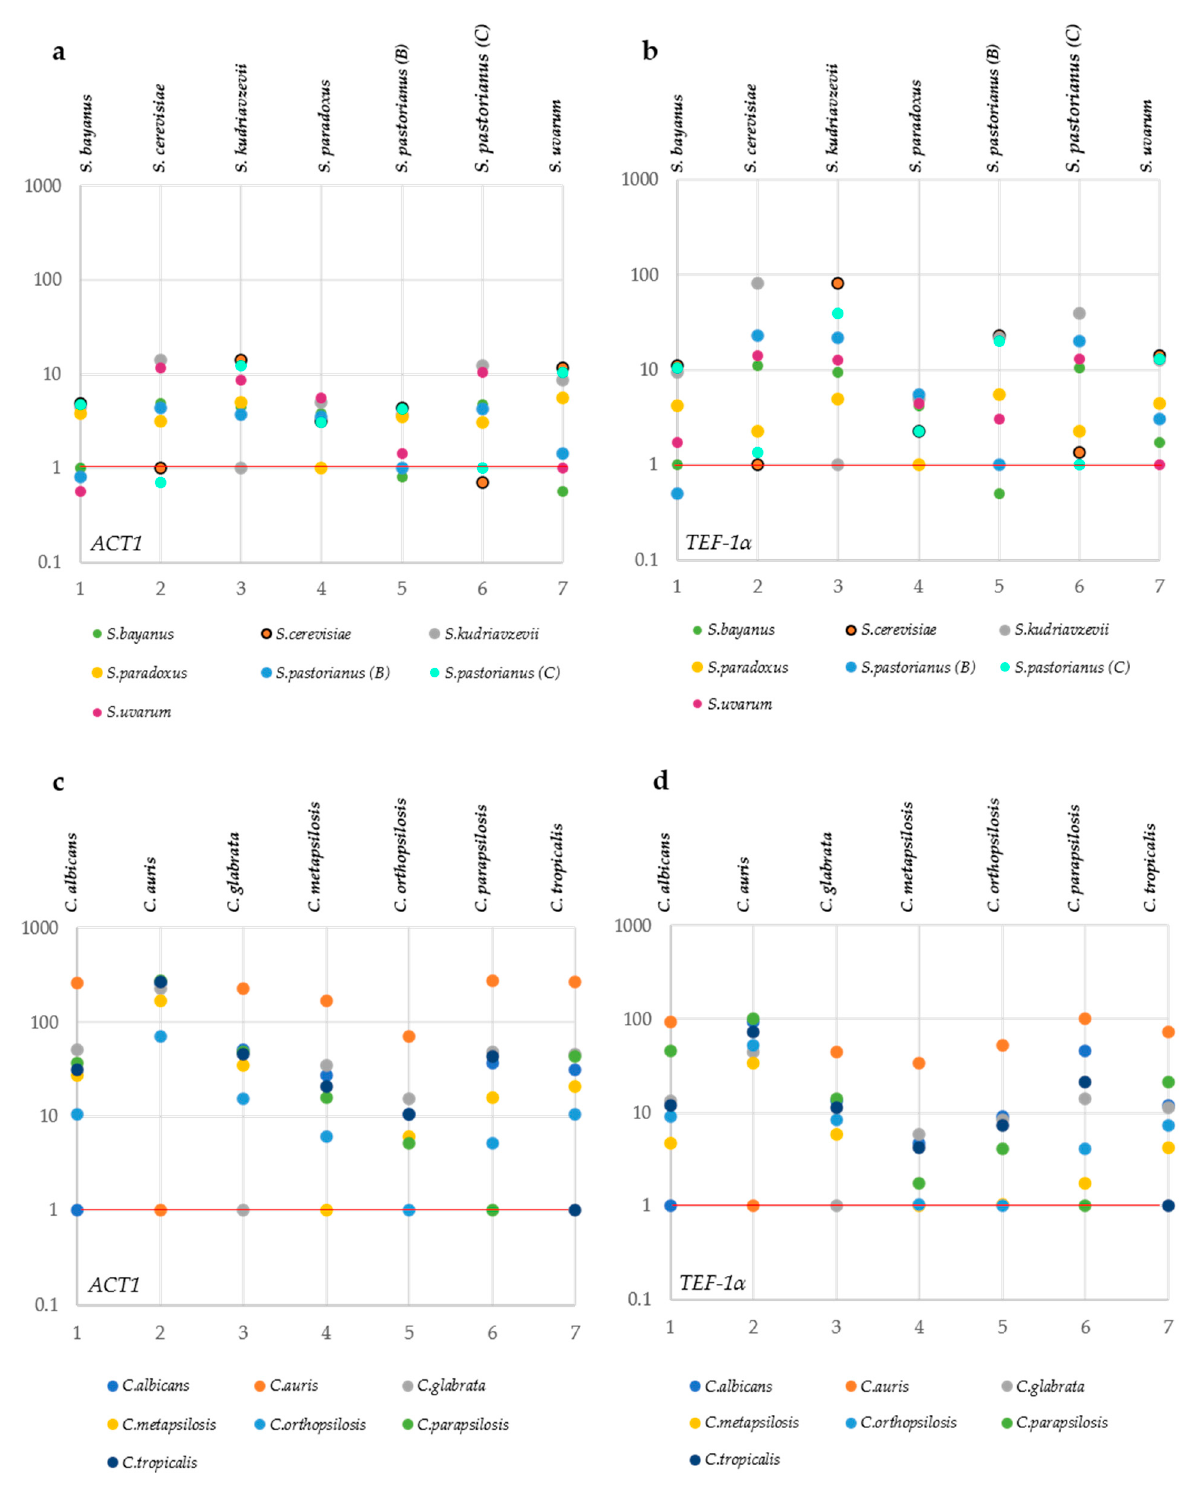
Figure 5. MeTRe among and within the Saccharomyces and Candida species for ACT1 and TEF1- α . Resolutions calculated for the genomic ACT1 and genomic TEF1- α of Saccharomyces are displayed in panels ( a , b ), respectively. Genomic ACT1 and genomic TEF1- α of Candida are reported in panels ( c , d ). Each column shows the resolution of the species positioned in a red line (reported above each column) from the other species under analysis. The species placed below the red line have no resolution with the species reported above each column. The values of MeTRe in log scale are reported on the y-axis, while the numbers on the x-axis correspond to the species involved in the study (and depicted at the beginning of each subpanel).